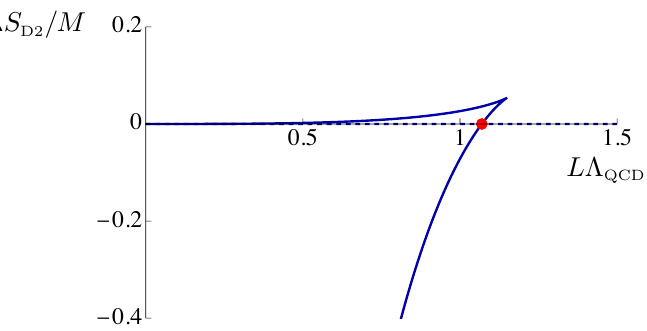
Figure 3. The action of a wrapped D2-brane, ∆ S The red dot stands for the transition between connected and disconnected configuration. Technical details of the calculation can be found in appendix